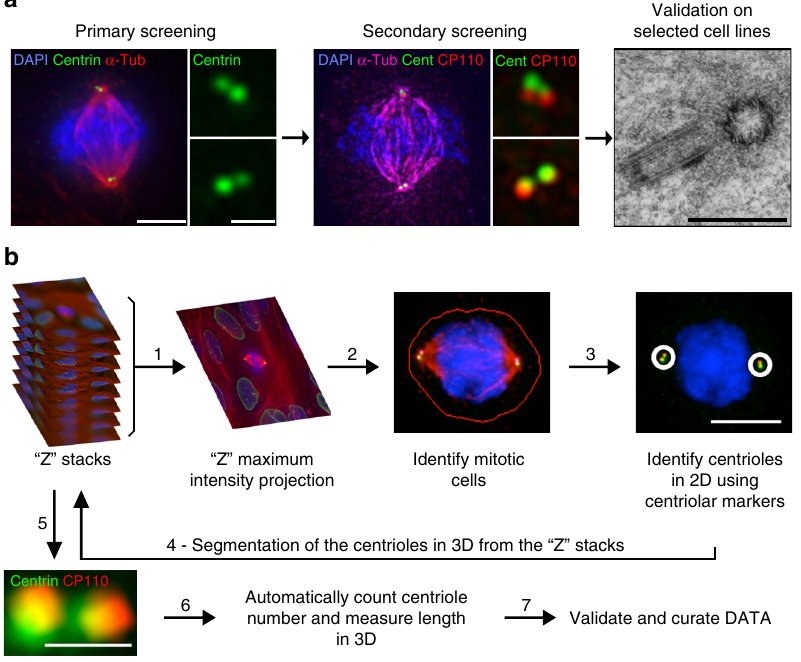
Fig. 1 Quantifying centriole number and length in cancer cells. a Screen overview. Step 1 and 2: primary and secondary immuno fl uorescence screenings of centrioles in the NCI-60 cancer cell lines using centrin (green) and centrin/CP110 (red) as centriolar markers, respectively. For each screening, we visually selected 50 mitotic cells per each of the cell lines and programmed the microscope to automatically acquire images as Z-stack using a ×100 objective. Cells were also stained with DAPI (blue) and α -tubulin antibody (red-primary screening, magenta-secondary screening). Scale bar 5 µ m, insets 1 µ m. Since centriole dimensions (250 nm width and 400 nm length) are close to the resolution limit of light microscopy, we selected some cell lines with extreme phenotypes for validation and further investigation, using transmission electron microscopy (TEM), scale bar 500 nm. Please note that all the pictures presented are from a non-cancerous cell line, RPE-1, used as a negative control in this study. b Overview of the semi-automatised quantitation of centriole alterations. Brie fl y, maximum intensity projections, obtained from all the stacks collected per fi eld of view, were created (step 1) and mitotic cells were automatically segmented from a background of interphasic cells using a spatial correlation coef fi cient based on both DAPI and α -tubulin signals, both of which are brighter in mitotic cells (step 2). Subsequently, centrioles were individually segmented using the centrin staining of each mitotic cell (step 3). In the secondary screening, centrioles were independently identi fi ed using both centrin and CP110 staining, and only the structures where these two different markers co-localised were kept for further analysis. Once identi fi ed in the 2D projections, all centrioles were segmented in three-dimensions (3D), automatically split into individual centrioles and measured in 3D (steps 4, 5 and 6). The number of centrioles per mitotic cell and their individual lengths were stored, together with a gallery of annotated images (see outputs of steps 2 and 3 for examples). These galleries were veri fi ed and manually curated twice (at steps 3 and 5). All remaining steps, from 1 to 6, were automatically performed by the developed algorithm. Scale bar 5 µ m, insets 0.5 µ